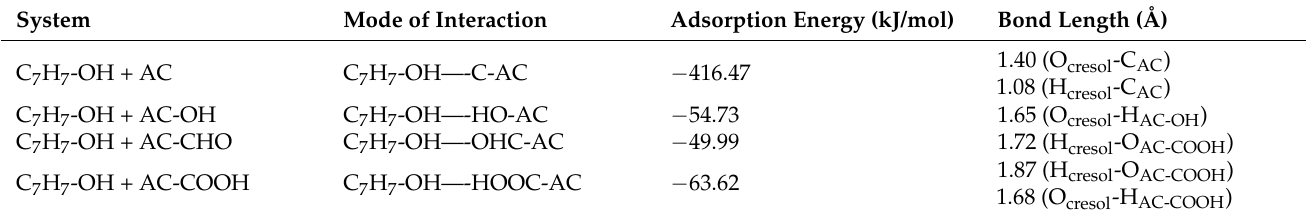
Table 1. Bond distance and adsorption energy of the adsorbate–adsorbent interaction .